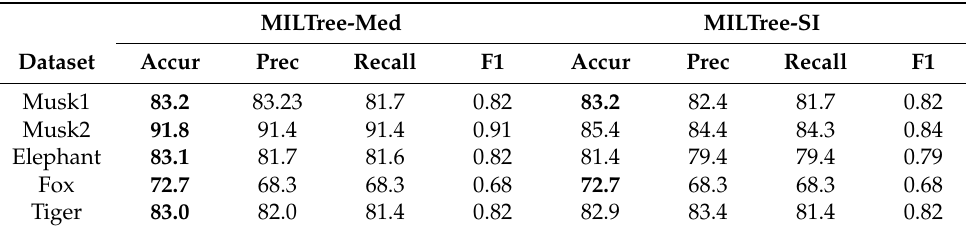
Bold values indicate the method that obtains the highest accuracy for each dataset. Table 4. Comparison between MILTree-SI / MILTree-Med and related methods from the literature on the benchmark